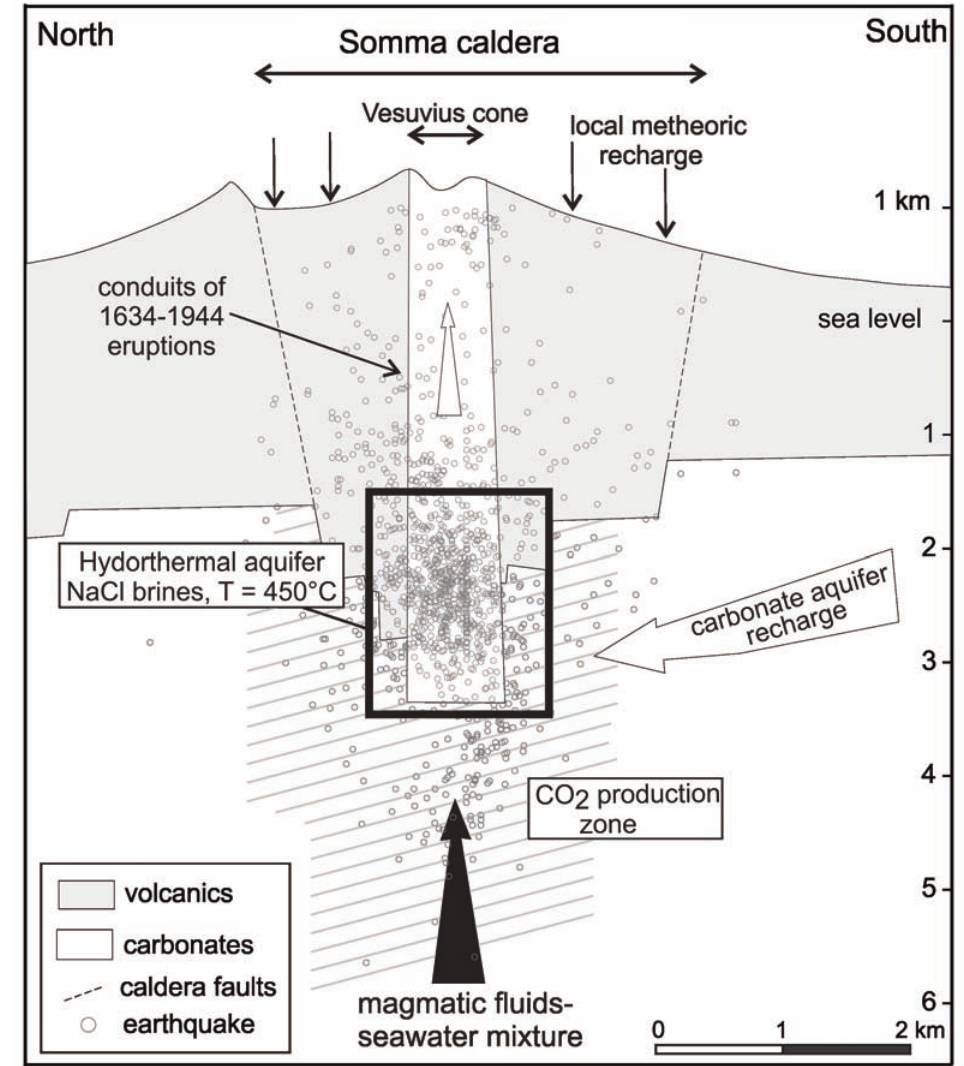
Figure 2. Conceptual geochemical model of the volcanic hydrothermal system of Vesuvius [after Chiodini et al. 2001], refined with the data from the present study (see Section 3.3.1). The seismic events registered in the 1995-1999 period [Saccorotti et al. 2002] are reported for